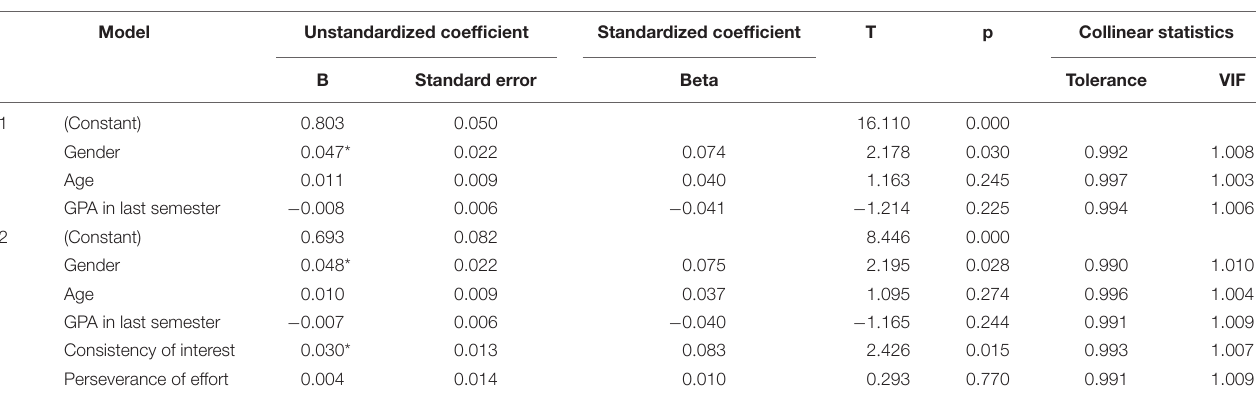
TABLE 3 | Results of regression analysis toward job-search